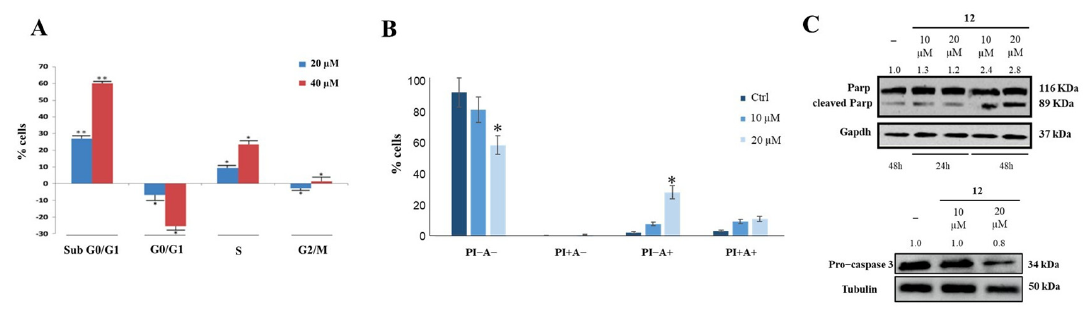
Figure 5. Effect of compound 12 on cell cycle and apoptosis. ( A ) HeLa cells incubation with compound 12 induced concentration-dependent arrest of the cell cycle in subG0/G1. ( B ) Compound 12 induced early apoptosis of HeLa cells. * p < 0.05 and ** p < 0.01 vs. Ctr. ( C ) Parp and pro − Caspase